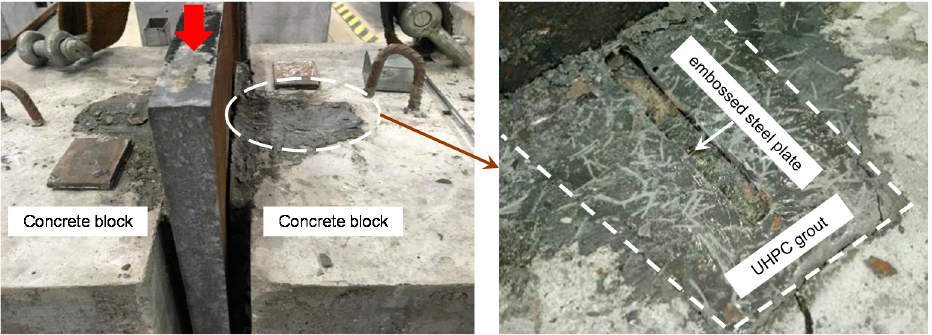
Figure 7. Slip between embossed steel plate and UHPC